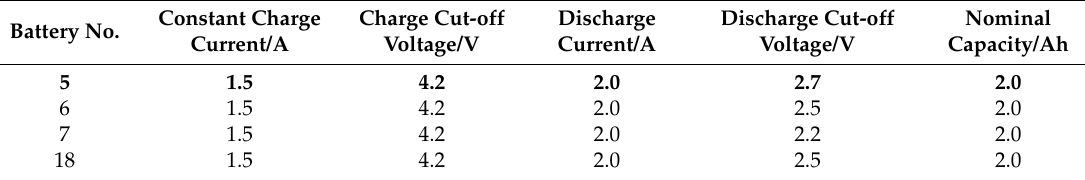
Table 1. Test condition of NASA battery data